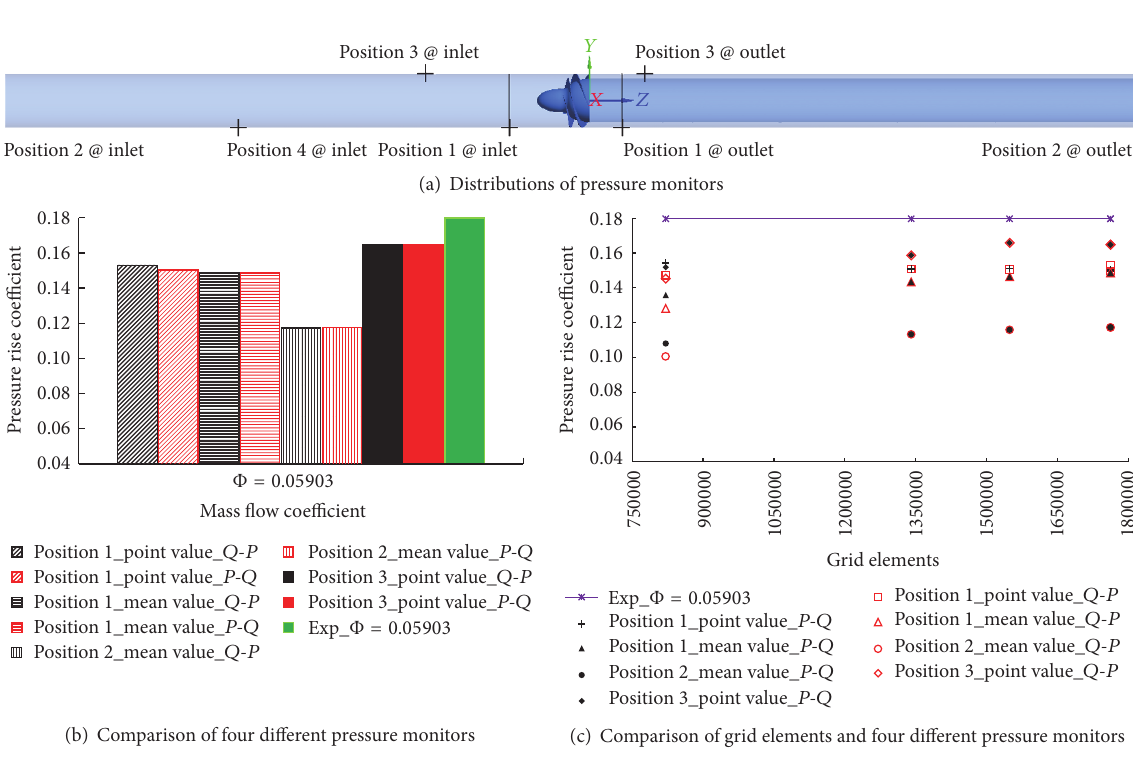
Figure 6: Comparison of different pressuring measuring positions at the flow coefficient of B = 0.05903